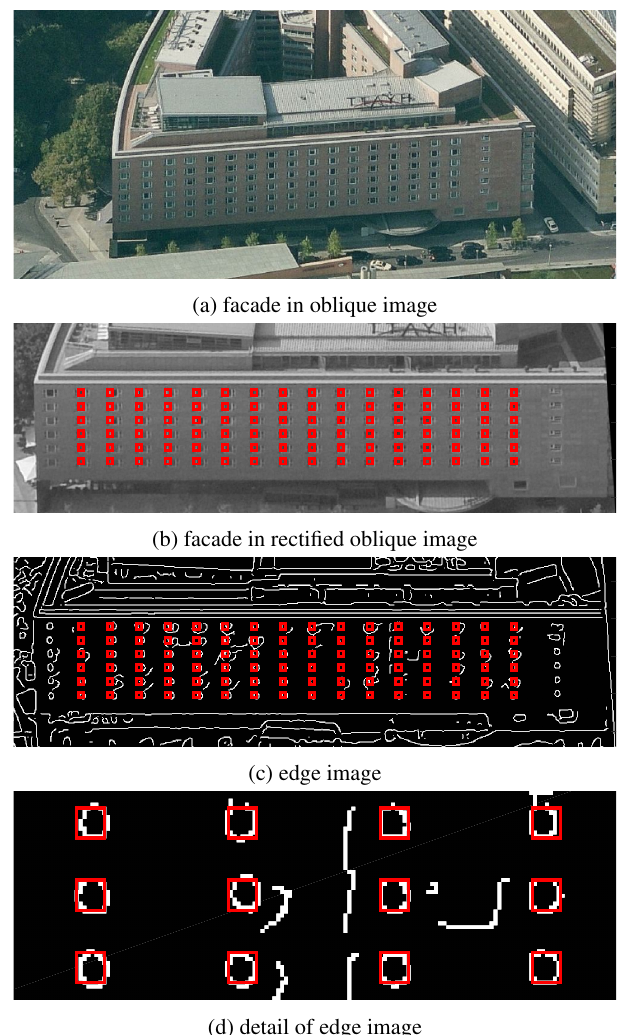
Figure 8. Hotel. (a) depicts the facade in the original oblique image. (b) shows the rectified facade overlaid with the extraction result in red. (c) displays the corresponding edge image. (d) is a zoom in of (c) for a better understanding.